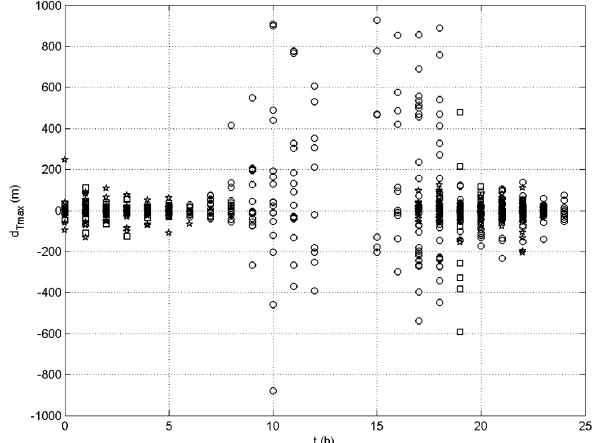
Figure 2. Time evolution of the maximum Thorpe displacements during a day cycle. The symbols are as follows: ◦ is for Almaraz94- 95 data, (cid:63) is for Sables98 data, and (cid:3) is for Sables2006 data. The error of Thorpe displacements is ± 1m.